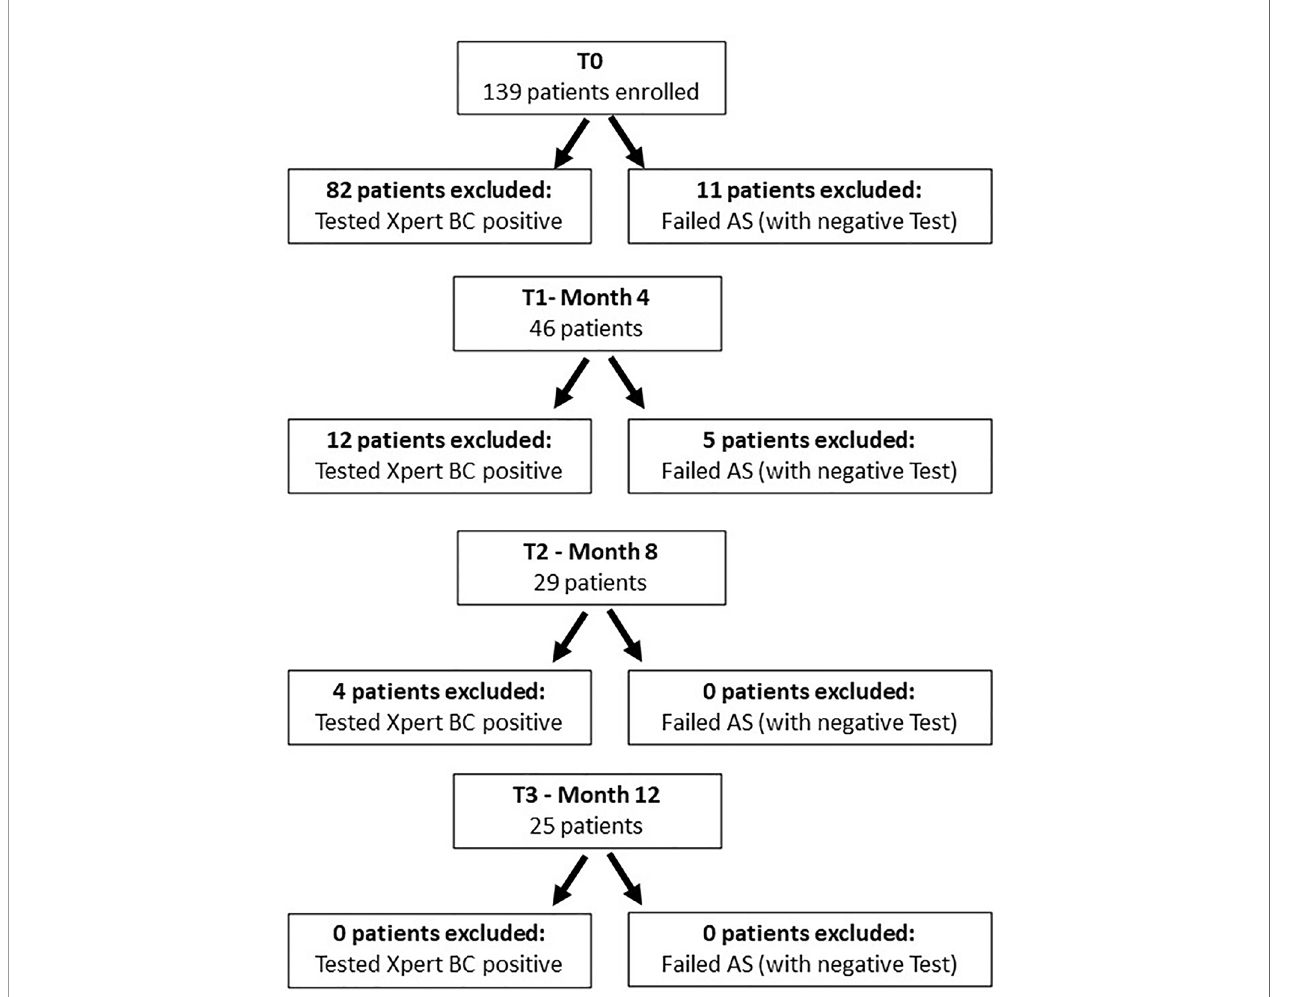
FIGURE 1 | Flow chart of enrolled and who dropped out of the study. To access the next “ time point ” , each patient had to have tested negative on the Xpert Bladder Cancer Monitor test and had none of the active surveillance failure criteria.